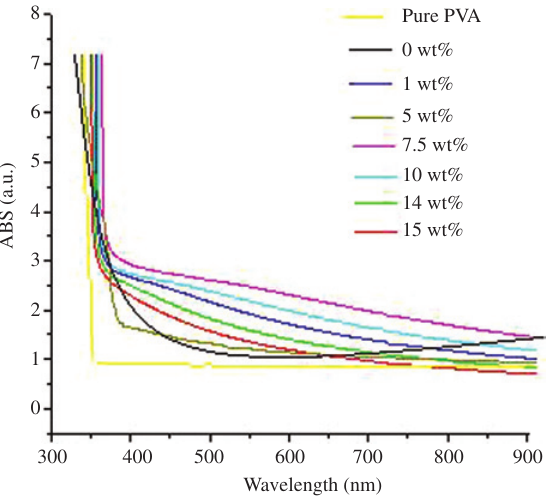
Figure 4: UV/visible spectra of PVA/( x )MWCNTs(15- x )ZnO nanocom- posites for various doping